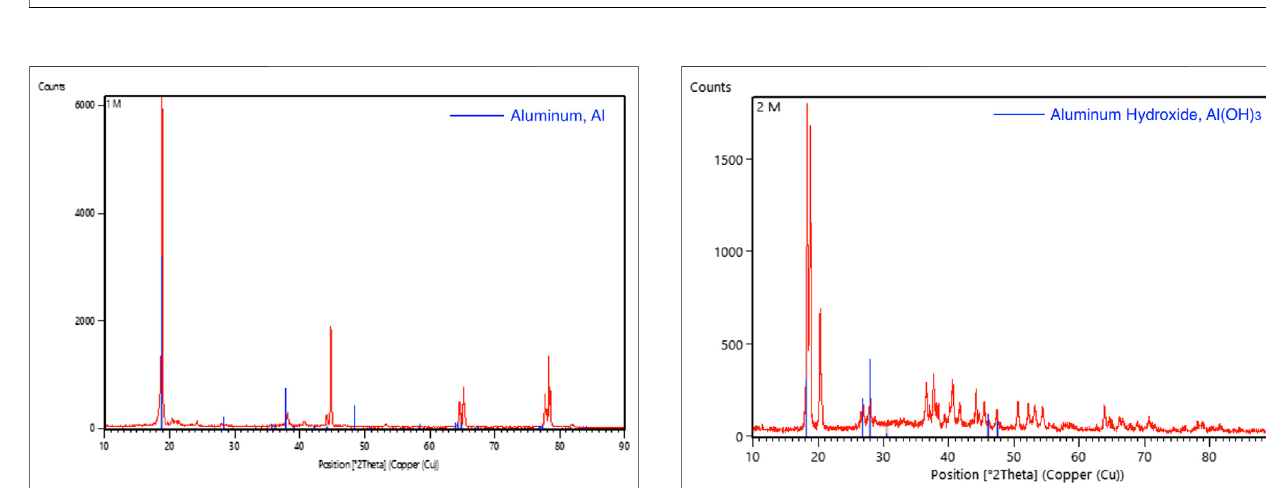
FIGURE 9 | SEM images 1000x magni fi cation of (A) aluminium before discharging (B) aluminum after discharging over 2 hours using 1 M KOH (C) aluminum after discharging over 2 hours using 2 M KOH (D) aluminium.